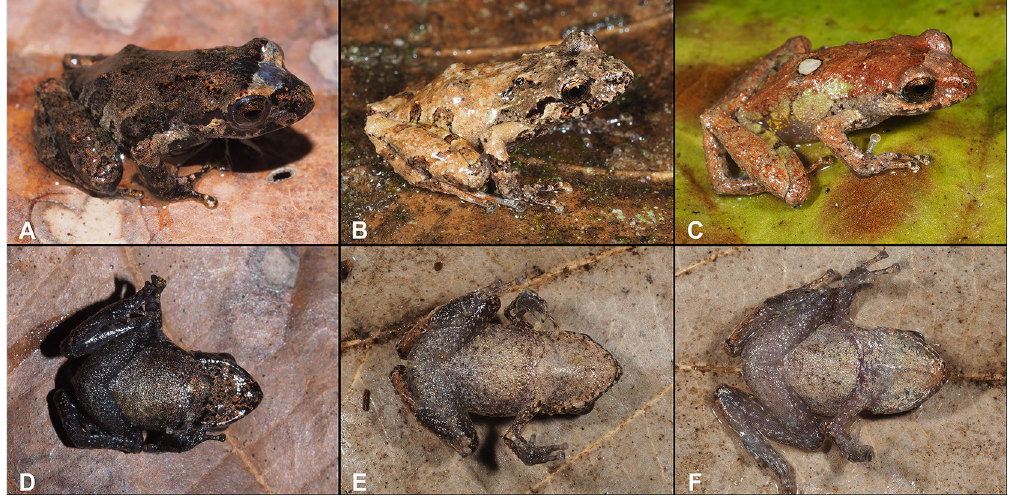
Fig 10. Color variation in juveniles of Pristimantis lojanus sp. nov. in life. A and D Paratype, (MUTPL 108), SVL 13.6 mm, Loja city, Quebrada Volcan; B and E Paratype, (MUTPL 628), SVL 18.1 mm, Loja city, Quebrada Quilloyacu; C and F Paratype, (MUTPL 704), SVL 17.8 mm, San Lucas, Acacana. A–C Dorsolateral views; D–F Ventral